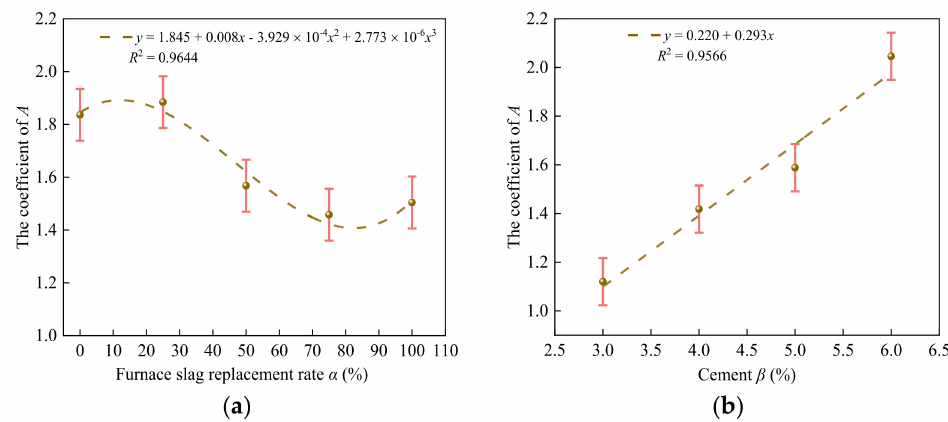
Figure 13. Fitting results of the furnace slag substitution rate α , cement ratio β , and coefficient A : ( a ) relation between the substitution rate α and coefficient A of the furnace slag and ( b ) relationship between the cement ratio β and coefficient A